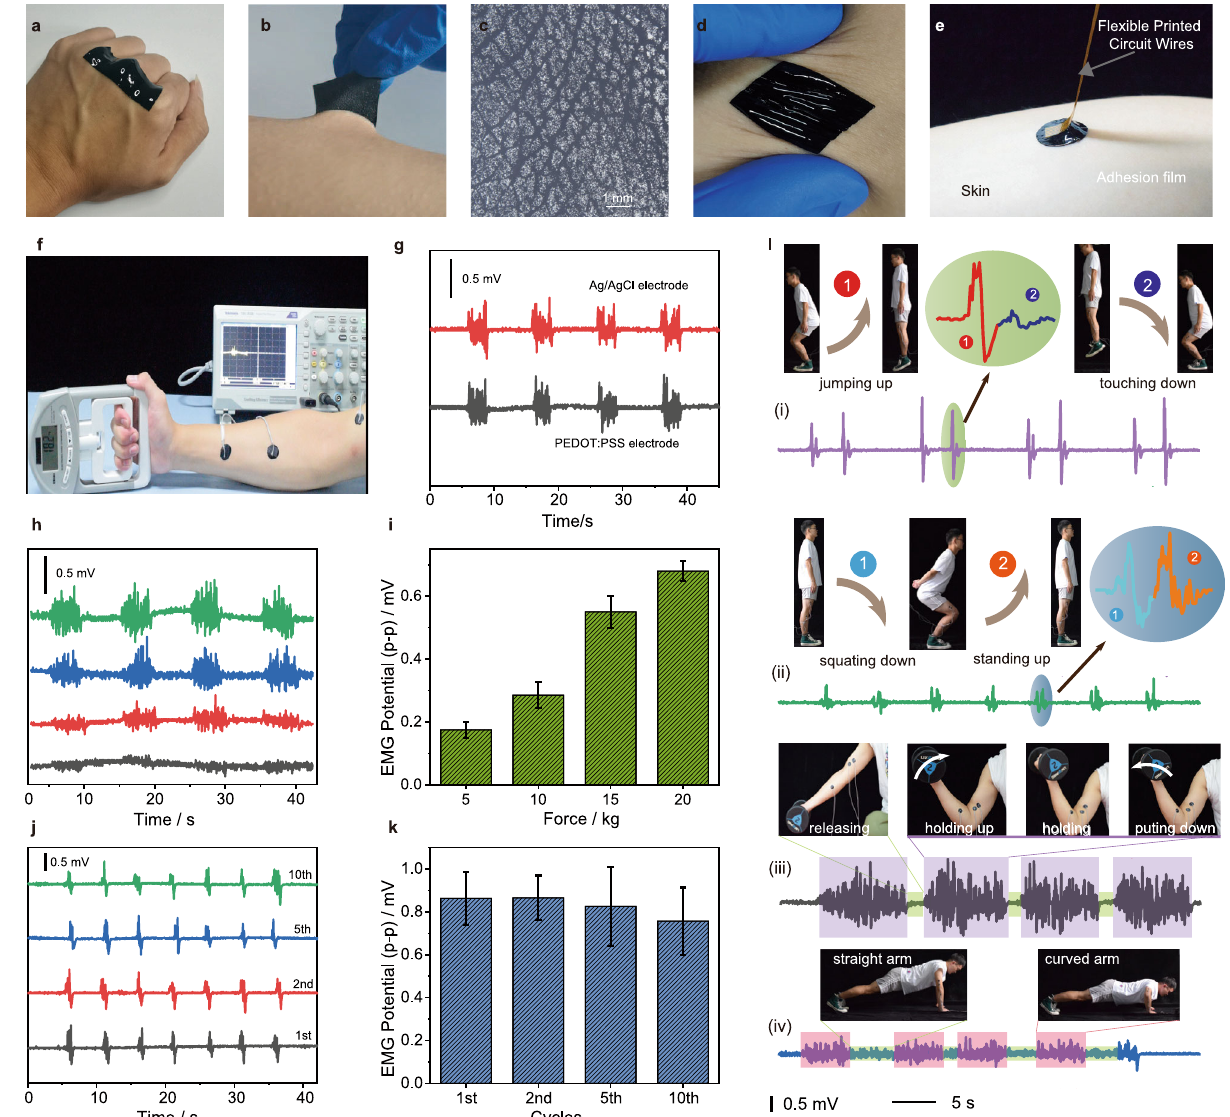
Fig. 5 Skin adhesion and electromyography (EMG) monitoring of human exercises by using SACP electrodes. a – b Adhesion of fi lms on joints of fi ngers ( a ) and skin of arm ( b ). c Images of skin texture patterned on an SACP fi lm after peeling off from the skin. d Images of SACP fi lms adhered on the skin under distorting. e Interface connection between skin and fl exible printed wires. f Image of an EMG test: SACP fi lm electrodes were attached to the skin near the muscle, and gripping forces were displayed by a dynamometer. g Comparison of EMG signals by using commercial Ag/AgCl electrode (red line) and SACP fi lm (black line). h – i EMG signals ( h ) and peak-to-peak value ( i ) under different gripping forces. j – k Stability of EMG signals ( j ) and corresponding peak to peak values ( k ) under repeated using test. The error bars show the standard deviations from at least three tests. l Detection of body exercises from EMG signal and the corresponding images (inset), jumping (i), squatting (ii), dumbbell lifting (iii), and push-up